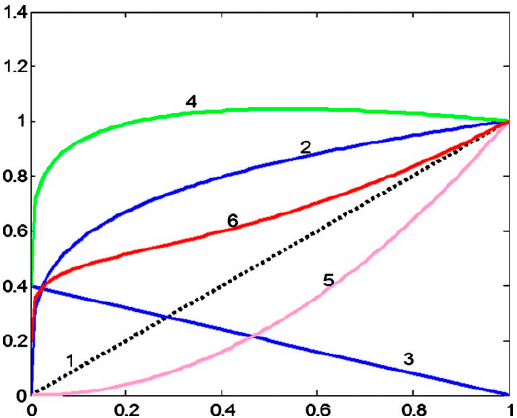
Figure 3. Nonlinear transfer function: Line 1 is the identity transformation; Line 2 is the energy function; Line 3 is the first-order constraint term; Line 4 is the sum of lines 2 and 3; Line 5 is the first-order edge-aware constraint term; Line 6 is the line 4 and 5 phase Add and divide the normalized transfer function by 2.